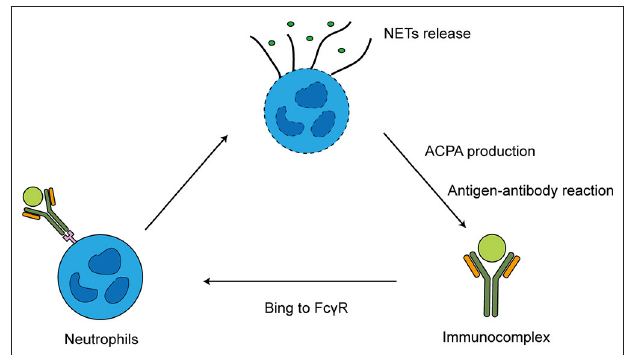
FIGURE 1 | Interaction of ACPA and